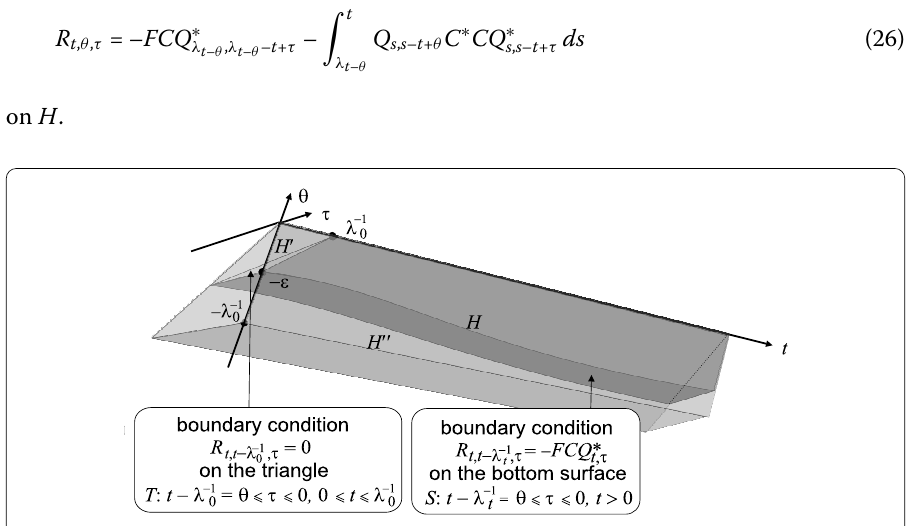
Figure 4 Bottom view of the regions H , H (cid:2) , and H